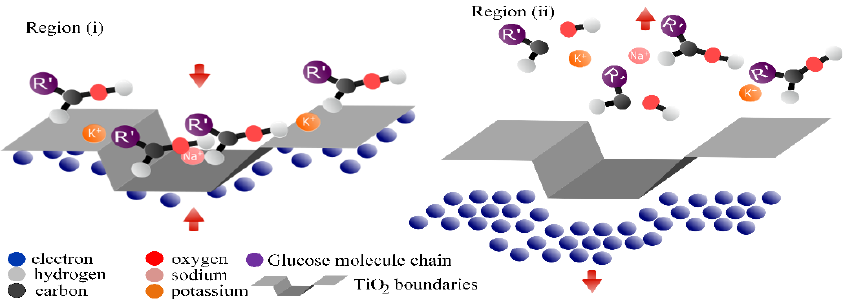
Figure 5. Proposed mechanism of interaction between ions, glucose molecules, and TiO 2 grain boundaries throughout the CV process.